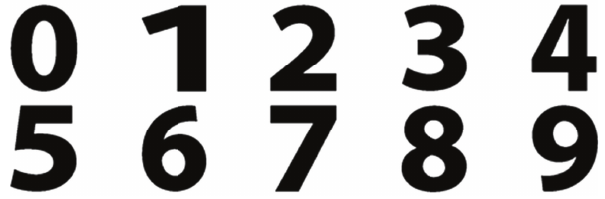
Figure 11: Letters for demonstrations.